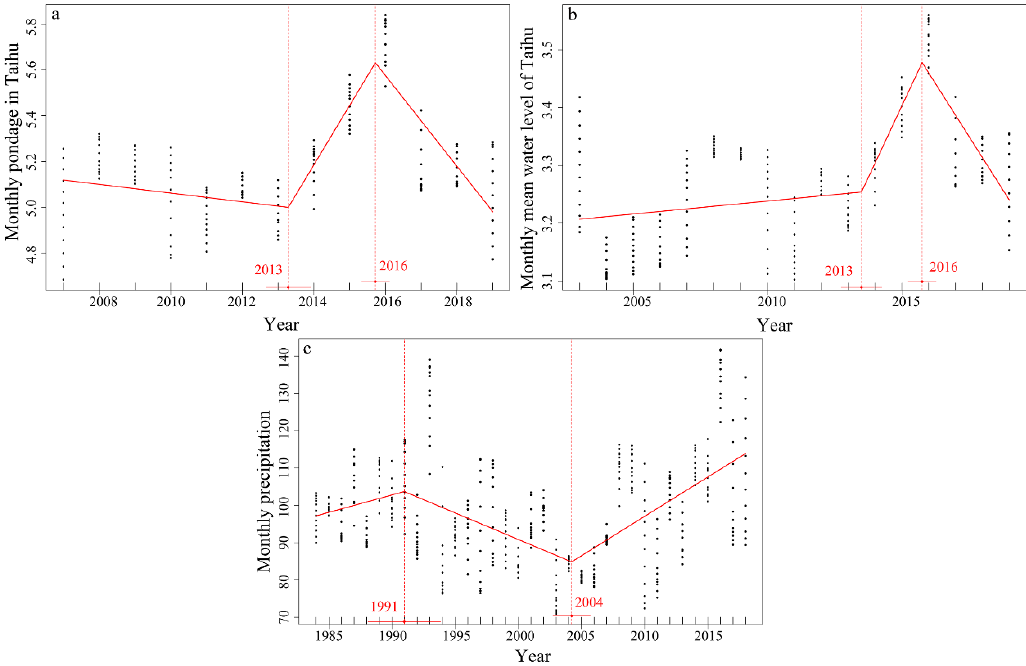
Figure 9. Inter-annual dynamics of precipitation, water level and pondage. ( a ): inter-annual changes of pondage from 2017 to 2019. ( b ): inter-annual changes of water level from 2003 to 2019. ( c ): inter-annual changes of precipitation from 1984 to 2018.